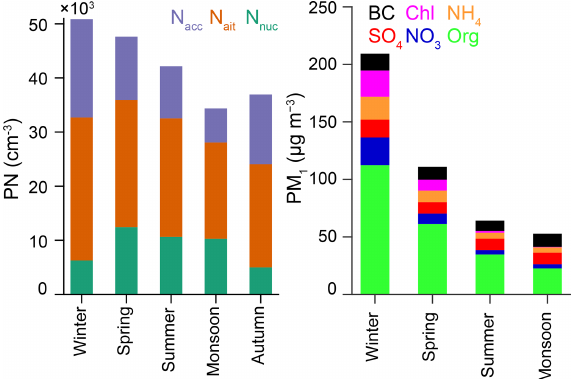
Figure 2. Average particle number (PN) levels for each sea- son by mode. The modes are based on scanning mobility par- ticle sizer (SMPS) observations, namely nucleation (12 < D p < 25nm), Aitken (25 < D p < 100nm), and accumulation (100 < D p < 560nm) modes. The PM 1 plot is reproduced from Gani et al. (2019) to illustrate seasonal variation in aerosol mass loadings. The PM 1 species are organics (Org), chloride (Chl), ammonium (NH 4 ), nitrate (NO 3 ), sulfate (SO 4 ), and black carbon (BC). While we had SMPS data for all seasons, we did not collect PM composition data during autumn due to instrumentation (aerosol chemical speciation monitor – ACSM) downtime.